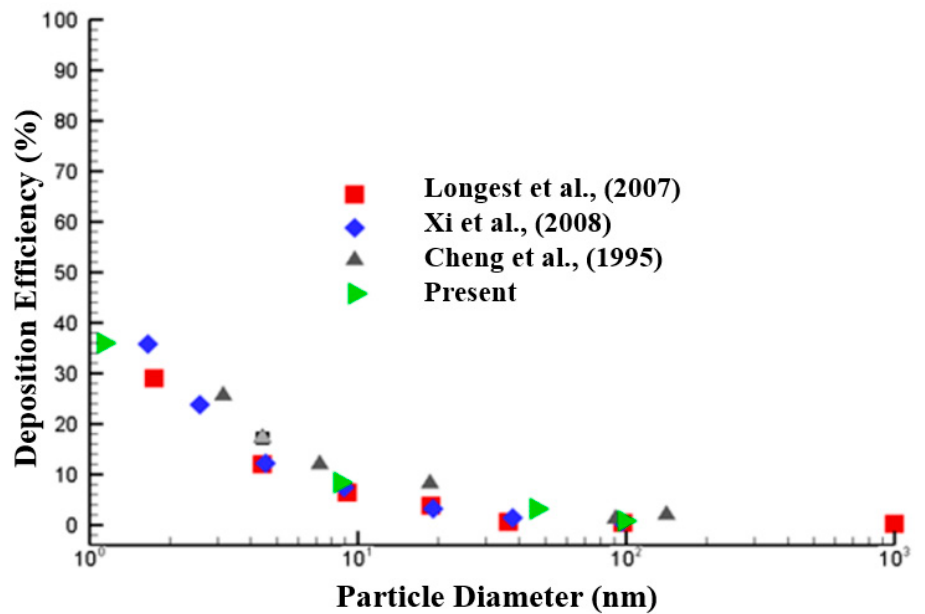
Figure 3. Deposition efficiency comparison with the published literature [68–70].